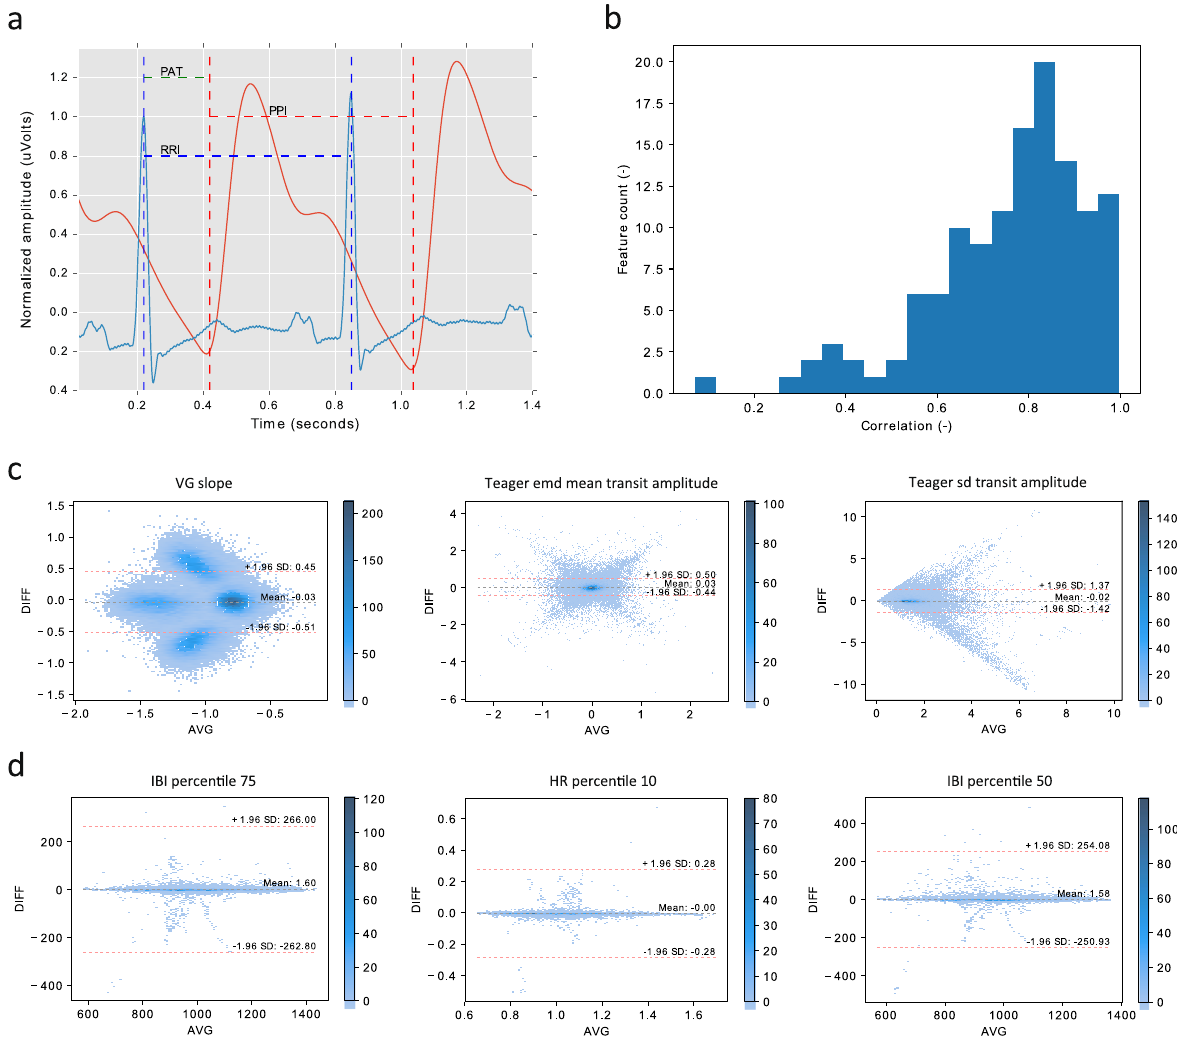
Fig. 4 Discrepancy between ECG- and PPG-derived HRV features. a Inter-beat interval. A sequence of inter-beat intervals as recorded by ECG (blue, RR-interval, RRI) and PPG (red, peak-to-peak interval, PPI). Pulse arrival time (PAT) is also shown. b Distribution of correlations between ECG-derived and PPG-derived HRV features. The features were obtained from ECG and PPG signals simultaneously recorded in the Eindhoven data set. The detailed description of the features can be found in Supplementary Table 1. c Bland-Altman density plots of example features with low correlation. From left to right, the features are the slope of network degree distribution using a visibility graph method, the mean of inter-beat-interval series amplitudes (after empirical mode decomposition), and the standard deviation of inter-beat-interval series amplitudes at transition points detected based on a Teager energy method, with a correlation coef fi cient of 0.069, 0.264, and 0.308, respectively. d Bland-Altman density plots of example features with high correlation. From left to right, the features are the 75th percentile of inter-beat intervals, the 10th percentile of heart rates, and the 50th percentile of inter-beat intervals, with a correlation coef fi cient of 0.997, 0.995, and 0.994, respectively. AVG and DIFF indicate the mean and the difference between ECG and PPG feature values,